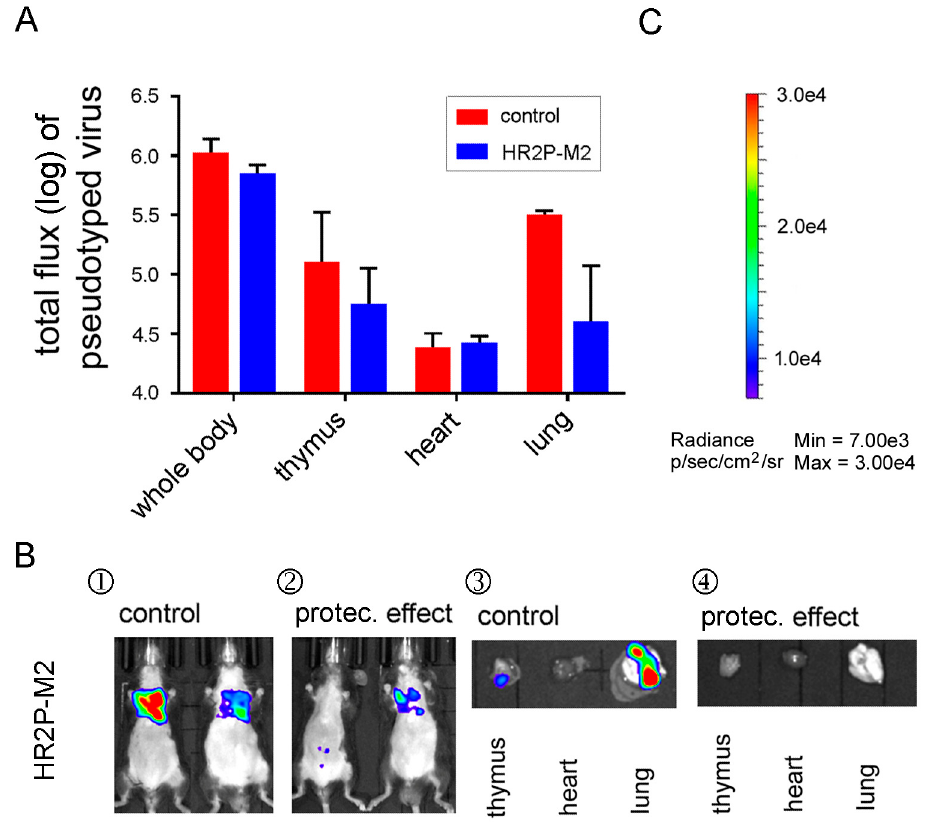
Figure 7. Inhibition of pseudotyped MERS-CoV infection in R26-hDPP4-knockin mice by peptide HR2P-M2. Mice were administered HR2P-M2 peptide or phosphate-buffered saline (PBS) I.T., respectively. Thirty min later, mice were infected I.T. with pseudotyped MERS-CoV (3.8 × 10 6.5 TCID 50 ). BLI images were taken on day 11 p.i., and pseudovirus signals were recorded for the whole body or specific organs. ( A ) Flux value of pseudovirus for assessment of the protective efficacy of HR2P-M2. ( B ) BLI images of whole mice or their organs. ( C ) Bar of photo flux; for details see Figure 2. Four mice were used for each group, and representative images are